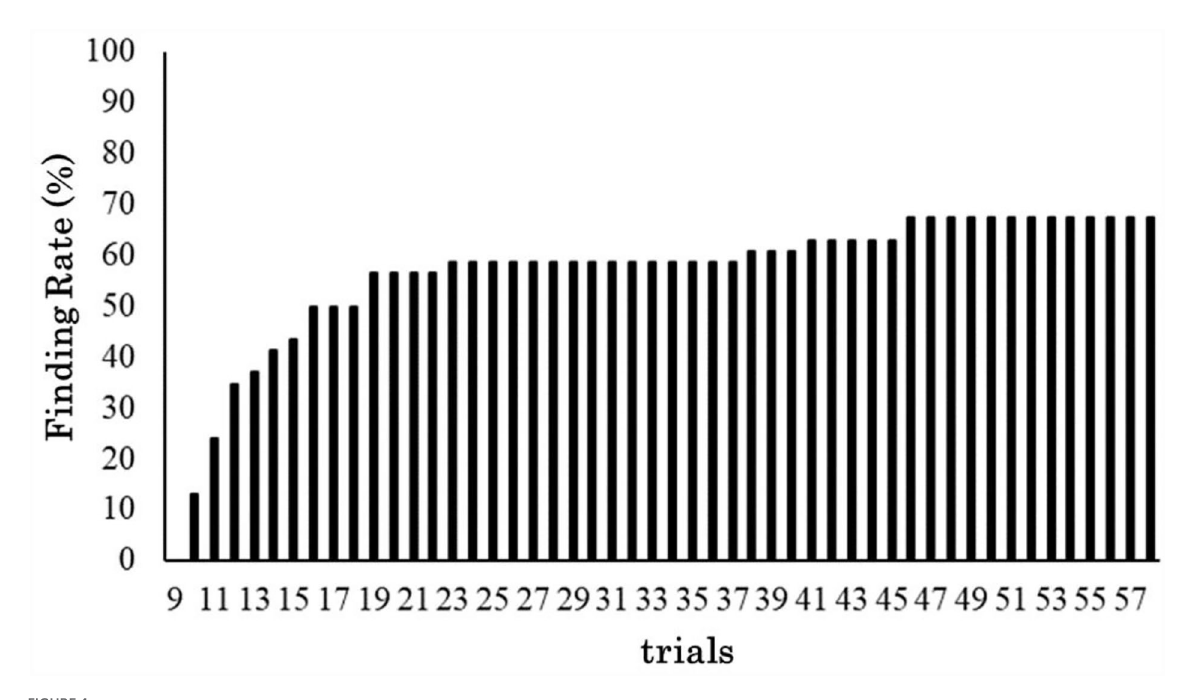
FIGURE4 Transition of the rate of finding an optimal